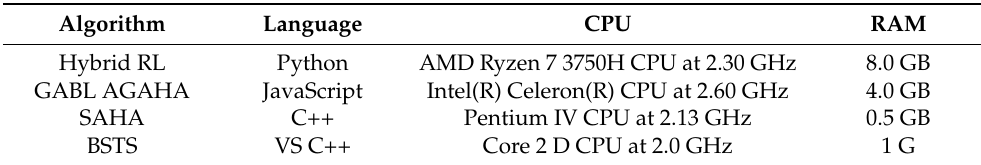
Table 2. Computational environments.